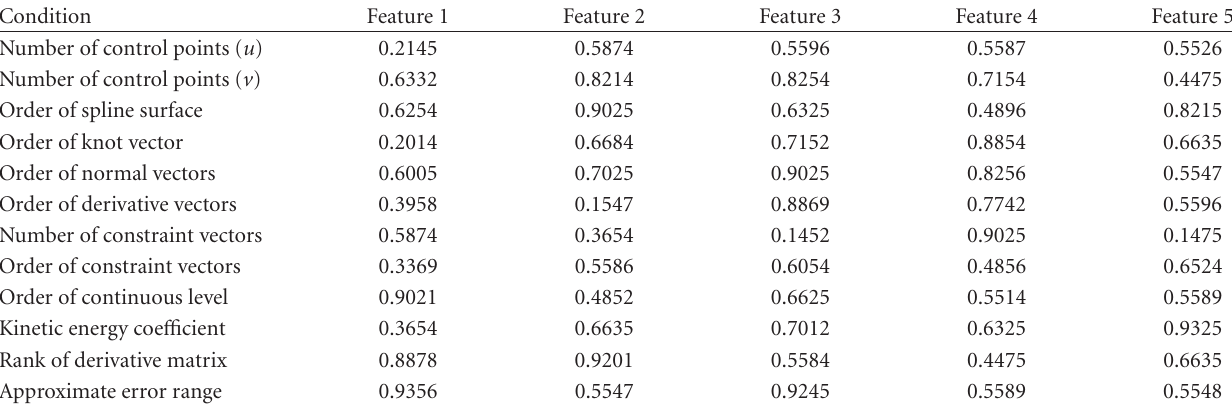
Table 12: Fuzzy relation degrees between experimental condition parameters and kinetic energy distribution surface features in scattered data interpolation surface.